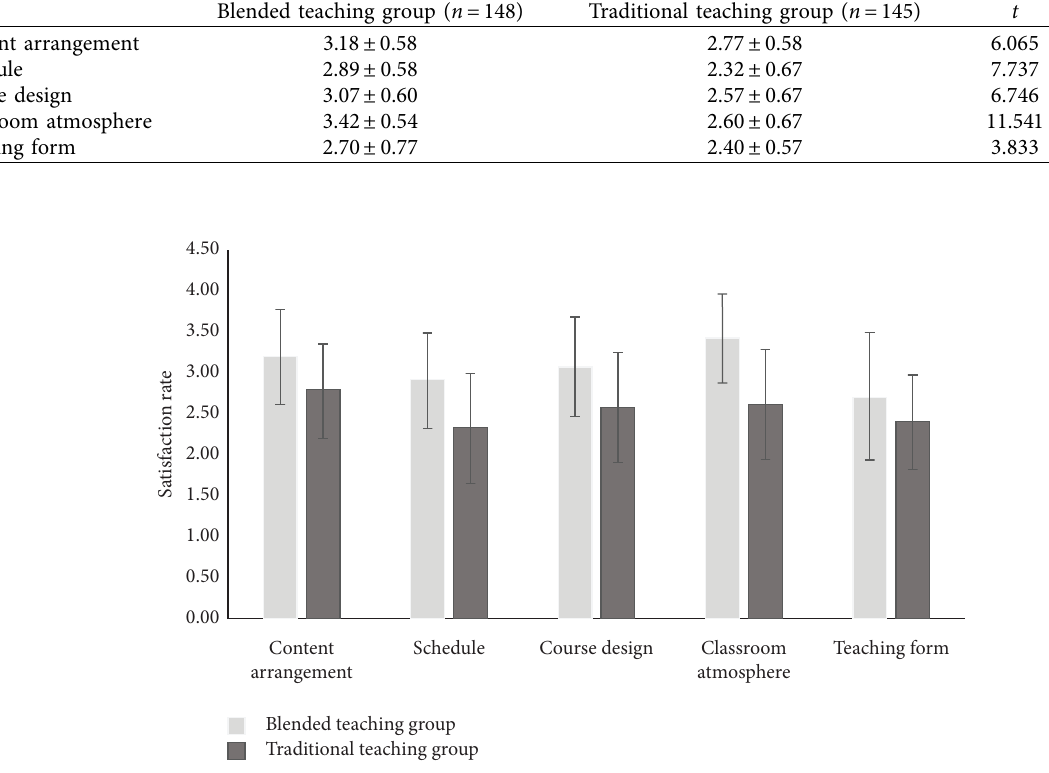
Figure 2: Comparison of satisfaction rate between the blended teaching group and traditional teaching group.